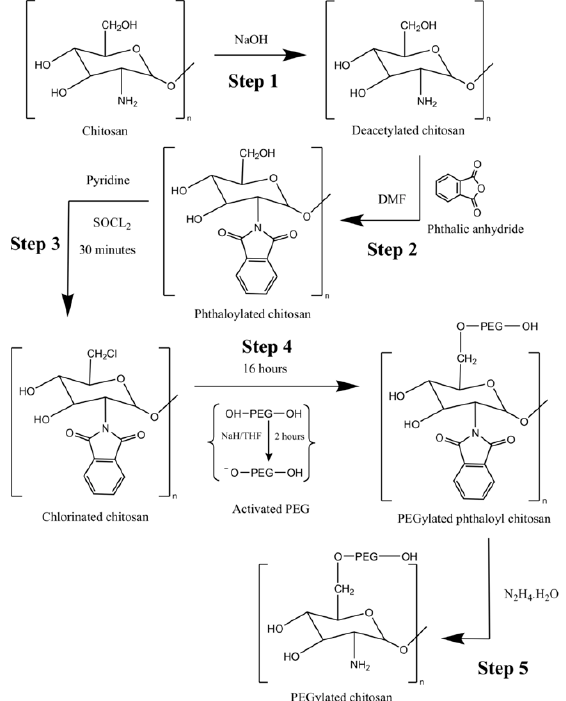
Figure 1. Reaction scheme of PEGylated chitosan.